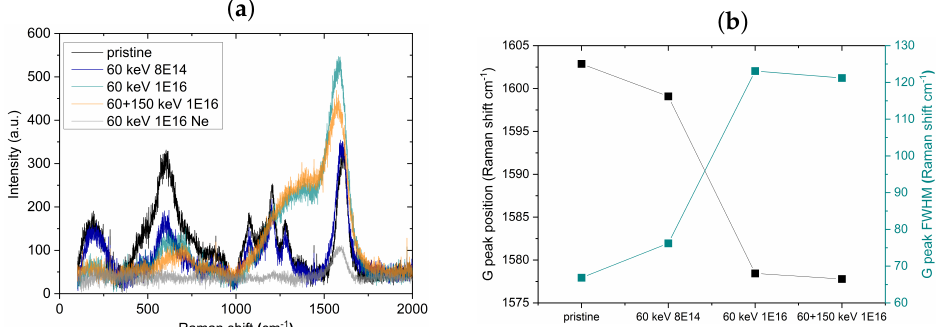
Figure 6. ( a ) Raman spectra of NT arrays before and after C and Ne bombardment. The carbon G peak is located at around 1580 cm − 1 –1600 cm − 1 . ( b ) The G peak position and the G peak full-width at half-maximum (FWHM) are plotted. The lines connecting the data points guide the eye. For Ne- bombarded NT arrays, the G peak is located at 1585.6cm − 1 . This figure constitutes a compilation of our final set of Raman spectra; data on pristine and 60 keV followed by 150keV C ion bombardment spectra were already included in Ref.